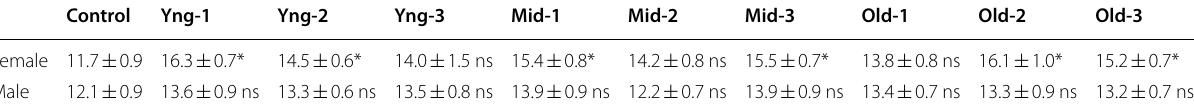
Table 2 Body weights (mg SE) of newly emerged female and male adults of Harmonia axyridis when feeding on artificial diets ±